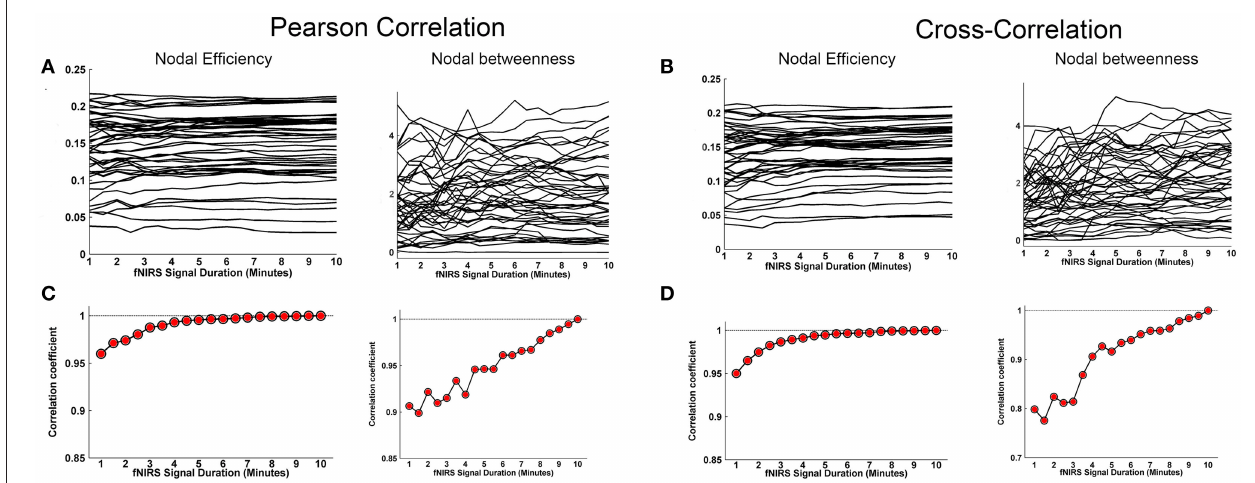
FIGURE 3 | Effect of fNIRS signal acquisition duration on the stability of nodal efficiency and nodal betweenness. The nodal efficiency and nodal betweenness in (A) and (C) were calculated from Pearson correlation-derived networks. (A) Graphs show magnitude of nodal efficiency and nodal betweenness plotted by the duration of fNIRS signal acquisition (1 10 min in bins incrementally larger by 30 s). (C) Between-map correlation coefficients calculated between short and long (10-min) signal ∼ durations for spatial pattern of nodal efficiency and nodal betweenness, respectively. The red-filled shapes indicate significant correlation between the spatial pattern of nodal efficiency or nodal betweenness associated with a given fNIRS signal acquisition duration and that computed using 10 min of fNIRS data. (B) was similar to (A) and (D) was similar to (C) except that the nodal efficiency and nodal betweenness were calculated from cross-correlation-derived networks.